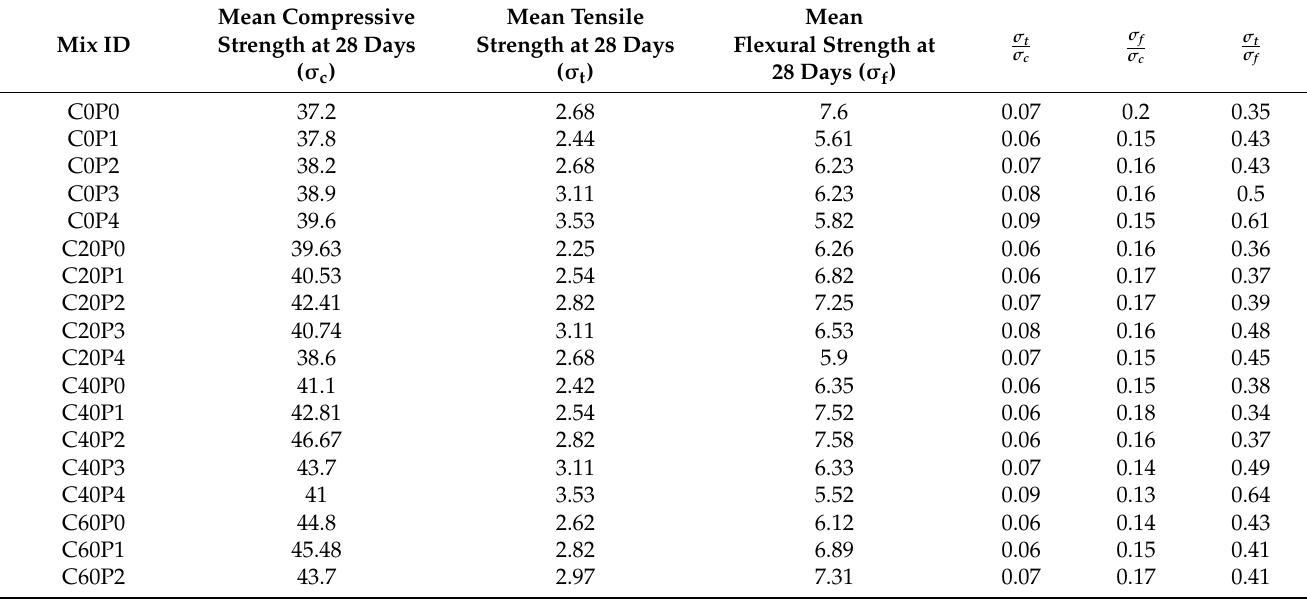
Table 7. Splitting tensile strength and flexural strength of